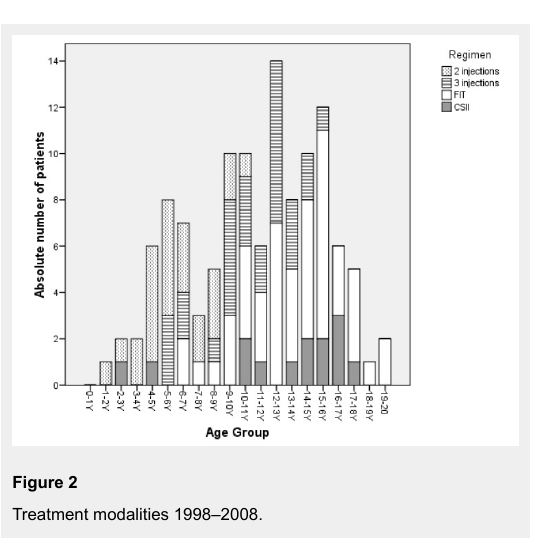
Age related use of different insulin treatment regimens in children and adolescents.